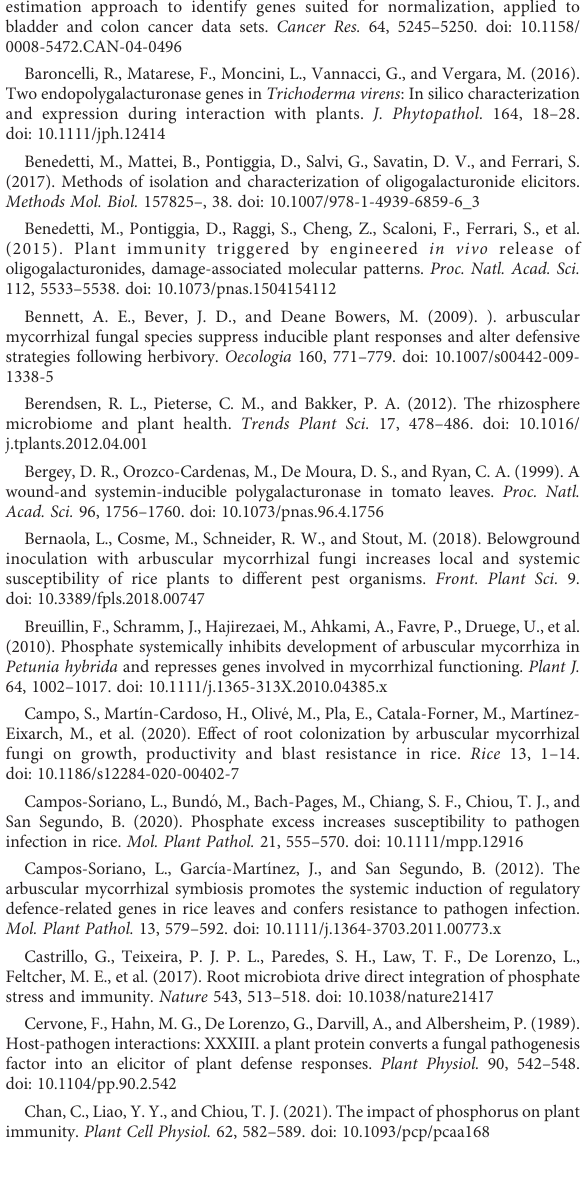
SUPPLEMENTARY TABLE 5 Fold changes in gene expression. Colors indicate up-regulation (red) and down-regulation (blue) and intensities are determined by the intensity of the changes: light color >1.5 or <0.75 and dark color >2 or <0.5 and signi fi cant effects arehighlighted inbold. (A) Effectof Pstarvation ongene expression in Nm plants (fold change in Nm and Fm plants fertilized at 0.3 vs 0.7 mM). (B) Effect of OG elicitation on gene expression in Fm or Nm plants grown at 0.3 mM and 0.7 mM P (fold change +OG/-OG). (C) Effect of AMsymbiosis ongeneexpression at 0.3mM and0.7mM P(fold change Fm/Nm). Bold numbers and asterisks indicate signi fi cant differences (t-